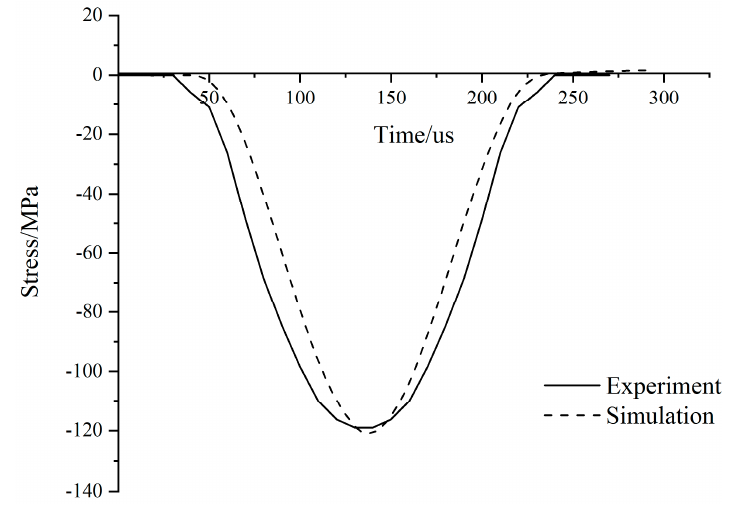
Figure 7. Experimental and numerical stresses of the incident bar.